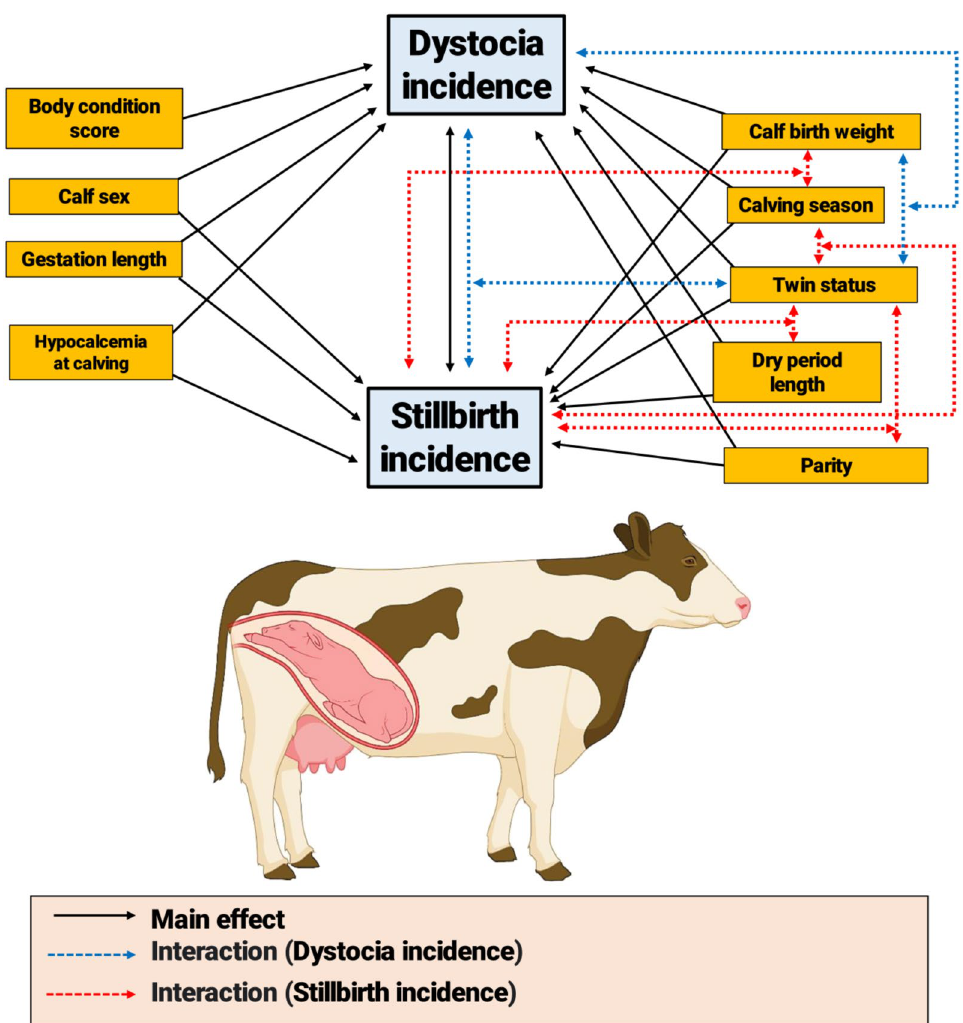
Figure 1. A causal diagram illustrating the main effects and interactions among cow-level factors associated with the incidence of dystocia and stillbirths using the results of multivariable logistic regression models. The Figure was designed by BioRender online software (https:// app. biore nder.